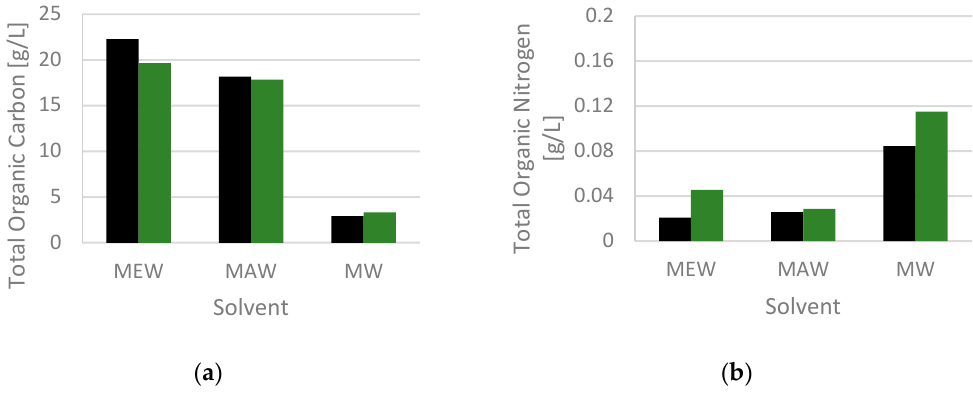
Figure 2. Total organic carbon ( a ) and total nitrogen ( b ) analysis performed on HEF samples obtained from the fractionation of pistachio hull (black) and SCG (green). The three solvent systems (MEW, MAW and MW) are compared in both